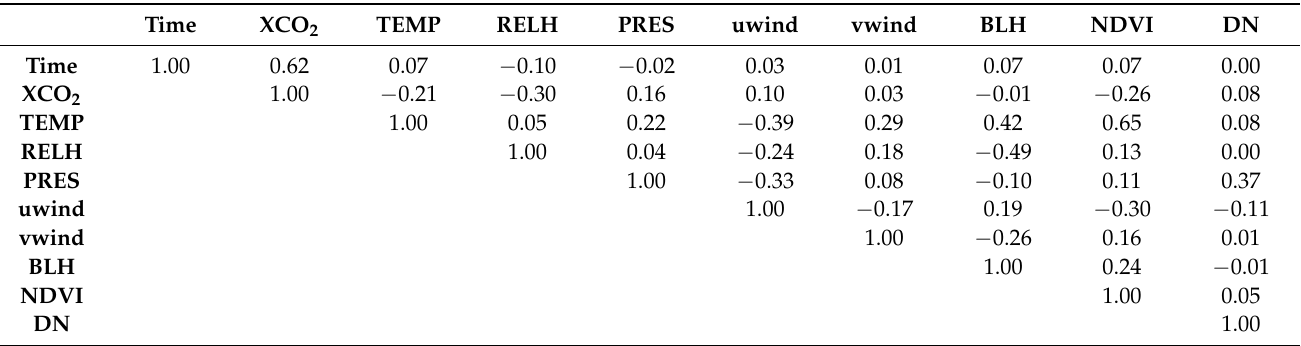
Table 2. Pearson correlation coefficient matrix of XCO 2 concentration reconstruction model with matching data set